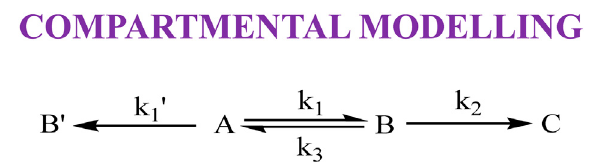
FIGURE 3 | Proposed general schematic of bi-exponential compartmental model kinetics for pollutant degradation (A, B, C, and B ′ : original pollutant, degradation intermediate, mineralized product, and byproduct intermediate, respectively).